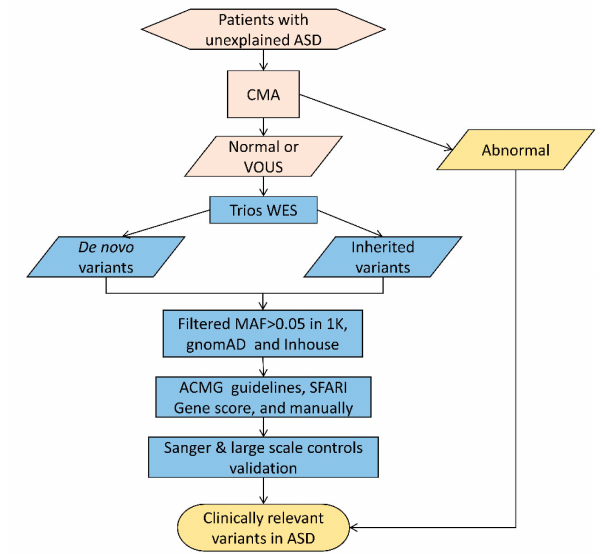
Figure 1. Flowchart for detecting clinically relevant variants in ASD by CMA and WES. ASD, autism spectrum disorder; CMA, chromosome microarray; HPO, human phenotype ontology; MAF, minor allele frequency; SFARI, Simons Foundation Autism Research Initiative; VOUS, variant of uncertain clinical significance; WES, whole-exome sequencing. First, we filtered for common variants with an allele frequency greater than 0.05; then, we evaluated the pathogenicity of the variants with reference to the ACMG guidelines, together with the SFARI gene score to identify candidate clinically relevant variants for autism. Meanwhile, considering the limited data on the Chinese population within the East Asian data in gnomAD databases, we validated clinically relevant variants that could be candidates for autism in 867 normal populations.